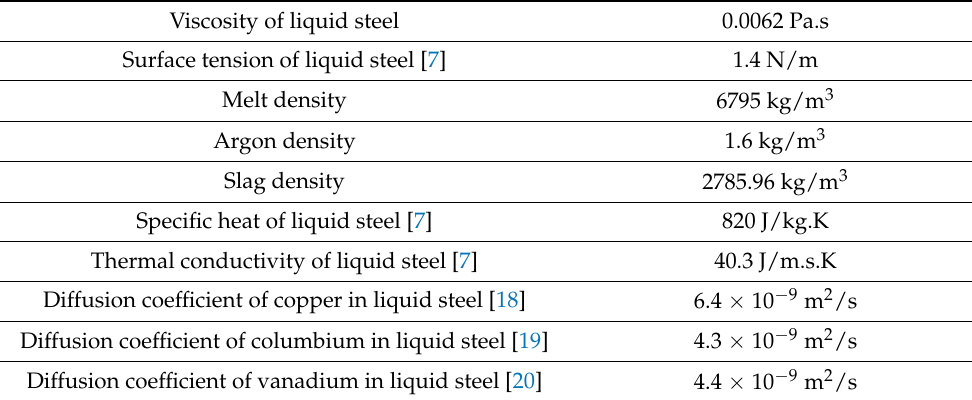
Table 1. Material